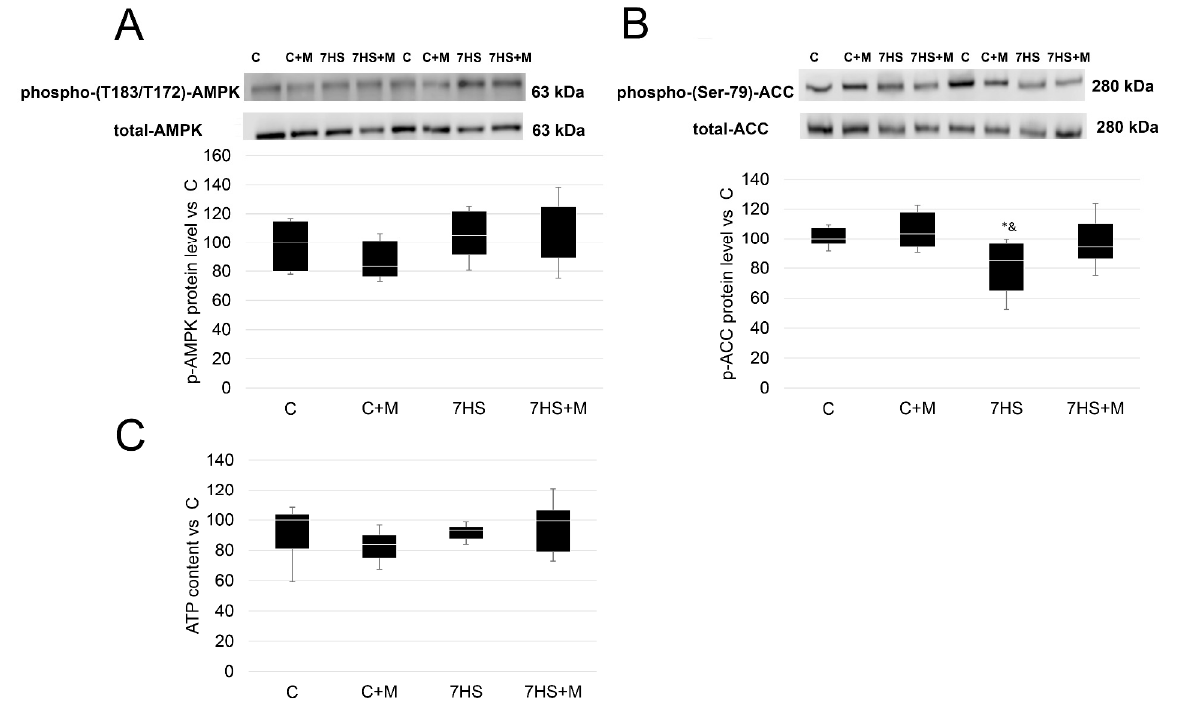
Figure 2. Western blot analysis of p-AMPK α 1/2(T183/T172) protein level ( A ), p-ACC (Ser 79) protein level ( B ), and ATP content ( C ) in rat soleus muscle in the control group (C), control group with metformin (C+M), 7-day hindlimb-suspended group (7HS), and 7-day hindlimb-suspended group with metformin (7HS+M). Data are shown as % of the control group, and median of the C group has been arbitrarily set to 100%. *—significant difference from the control group. &—significant difference from C+M group ( p < 0.05). Box plots show 25–75 percentiles and median values, and the whiskers represent the minimum and the maximum; n = 8/group.